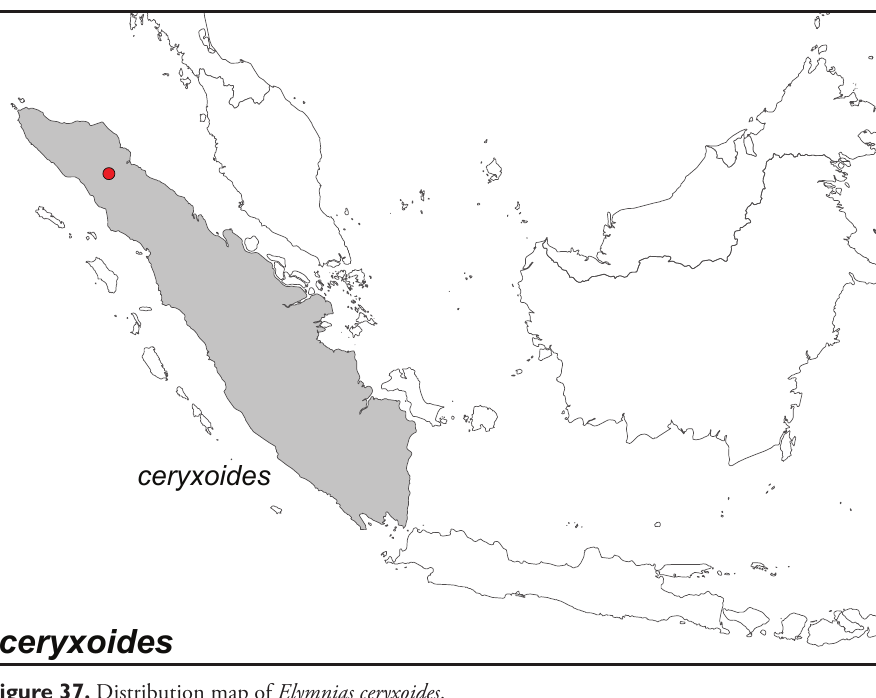
Figure 37. Distribution map of Elymnias ceryxoides .